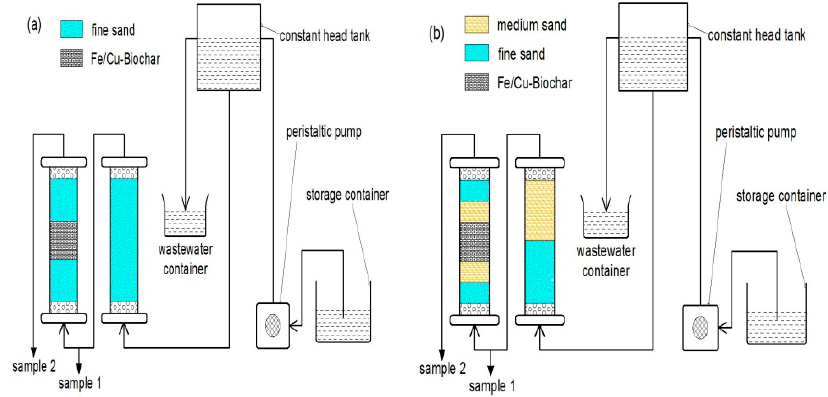
Figure 1. Schematic diagram of the experimental apparatus: ( a ) contaminant transport and removal experiment in a saturated homogeneous columns system; and ( b ) contaminant transport and removal experiment in saturated heterogeneous columns. Table 1. Experimental configurations and specifications of the applied homogeneous systems.